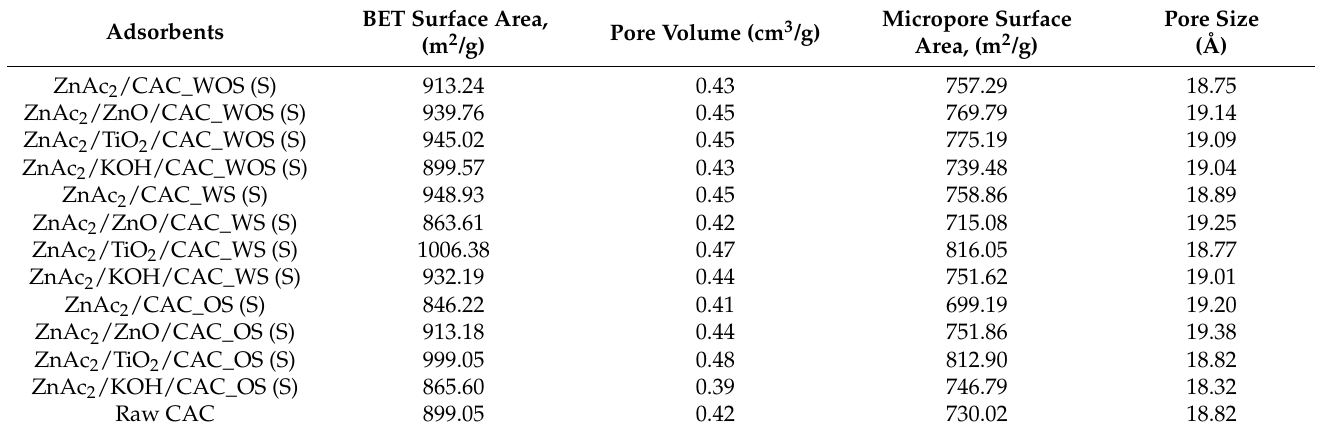
Table 5. Surface properties of CS/CAC